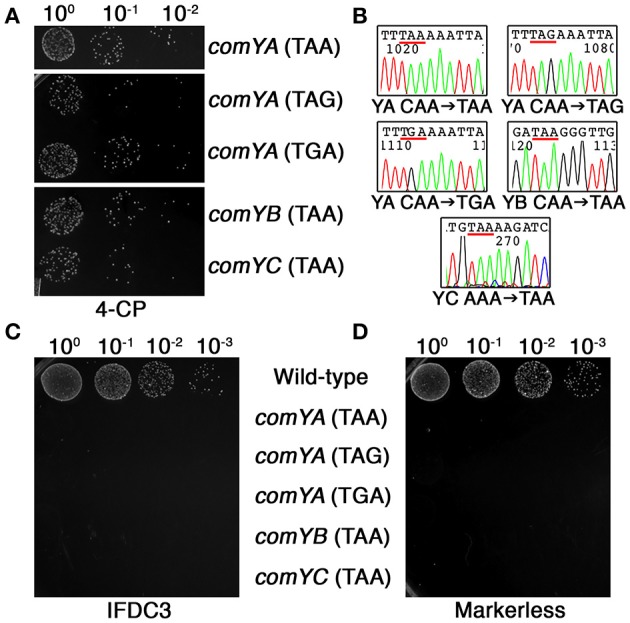
Markerless nonsense point mutations in the comY operon. (A) Multiple markerless nonsense point mutations were introduced into comYA, comYB, and comYC. Shown here are the results obtained from the final 4-CP selection step. The mutated genes and the sequences of the engineered stop codons are indicated on the right side of the image. (B) Multiple markerless nonsense point mutant clones were sequenced to assess mutation fidelity. Shown here are representative chromatograms with the engineered stop codons underlined in red. The identity of the mutated genes (comYA, YB, or YC) and their engineered point mutations are listed under their corresponding chromatograms. (C) Each of the parental allelic replacement mutants containing IFDC3 was tested for their natural competence ability. Shown here are the resulting transformants obtained after transformation with 2 μg ml−1 of the E. coli-Streptococcus shuttle vector pDL278. Strain identities are indicated on the right side of the image. (D) The same transformation experiment was repeated using confirmed markerless nonsense comY point mutant strains. Strain identities are indicated on the left side of the image.